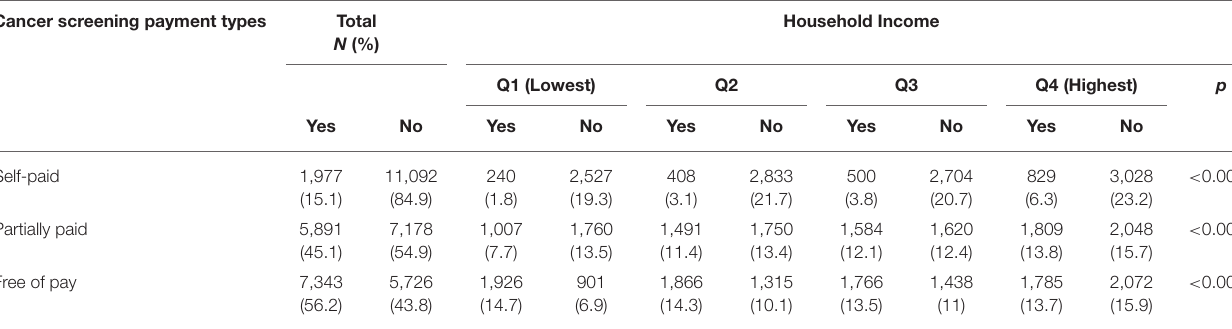
TABLE 2 | Frequency distribution of types of cancer screening by household income. Cancer screening payment